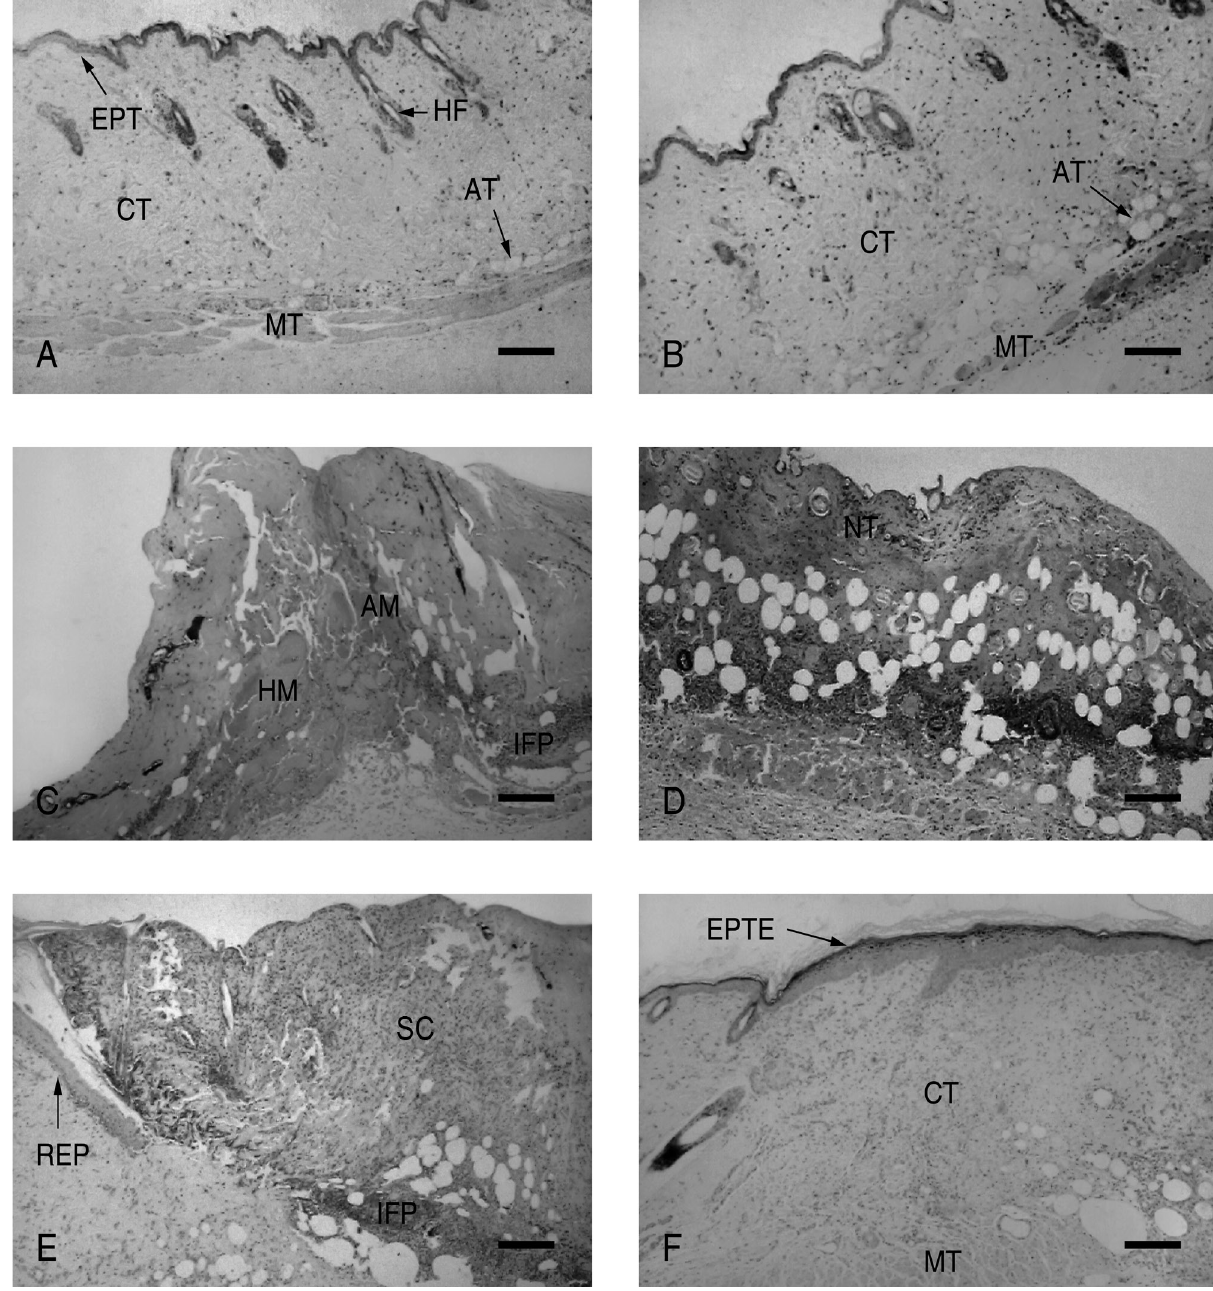
Figure 2. Histological analysis of skin of mice injected with 100 µg/50 µL of Bothrops cotiara venom. Control sites were injected with an equal volume of 0.9% NaCl solution. Panels correspond to the panoramic view of HE-stained sections from: ( A ) control group, ( B ) four hours after inoculation, ( C ) 24 hours after inoculation, ( D ) three days after inoculation, ( E ) seven days after inoculation, and ( F ) 21 days after inoculation. HF: hair follicles; AM: amorphous tissue; EPT: epithelial tissue; EPTE: thick epithelial tissue; SC: scab; HM: hemorrhage; IFP: PMN infiltrate; AT: adipose tissue; CT: connective tissue; MT: muscular tissue; NT: necrotic tissue; REP: epithelization area. Bars at the bottom of each panel indicate 250